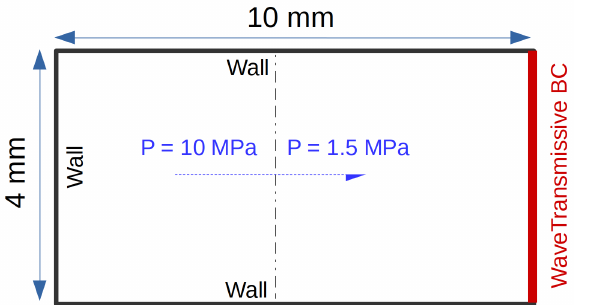
Figure 16. Numerical setup for two-dimensional geometric pressure wave test using the same dimensions of the expansion chamber section, with the same cell density. The initial fields are set with a pressure wave front that propagates towards the outlet